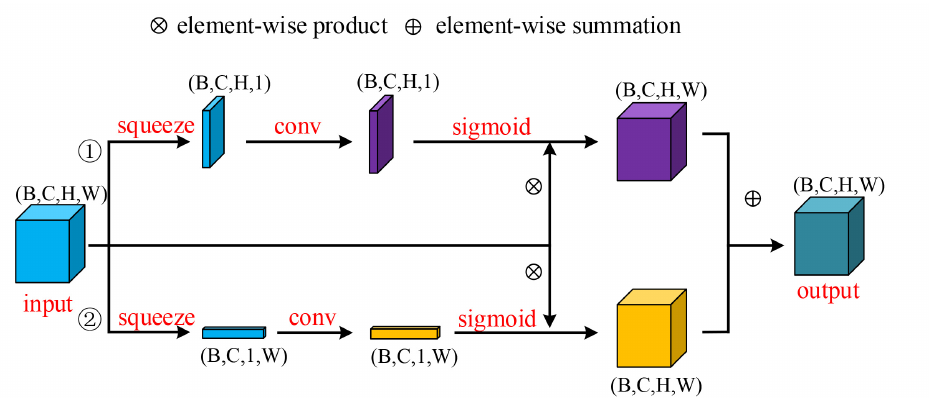
Figure 6. More detailed structure of the row-column attention